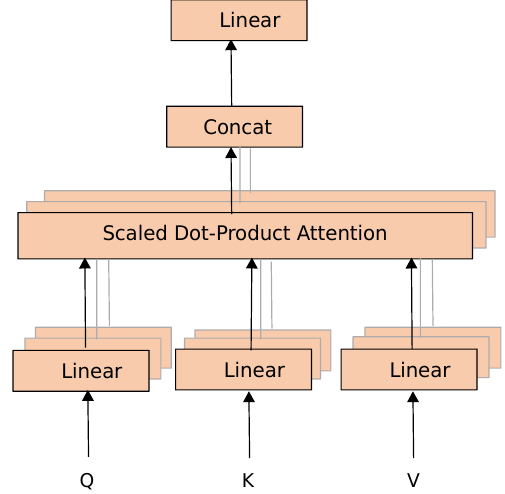
Figure 2. Multi-headed